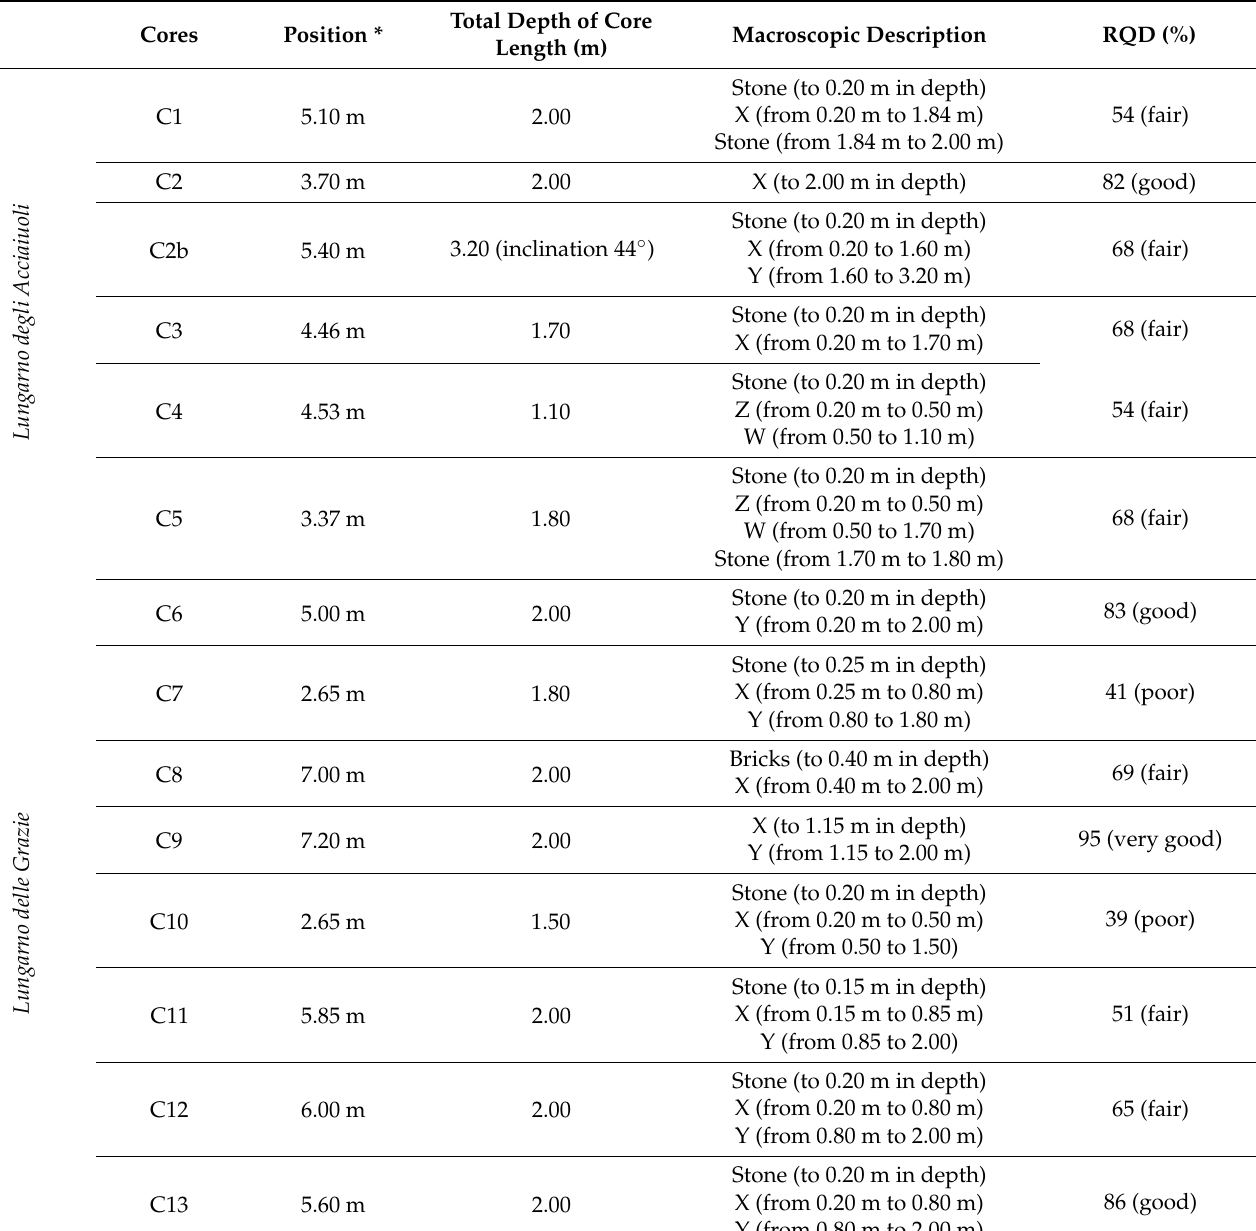
Table 1. Macroscopic descriptions of cores and RQD